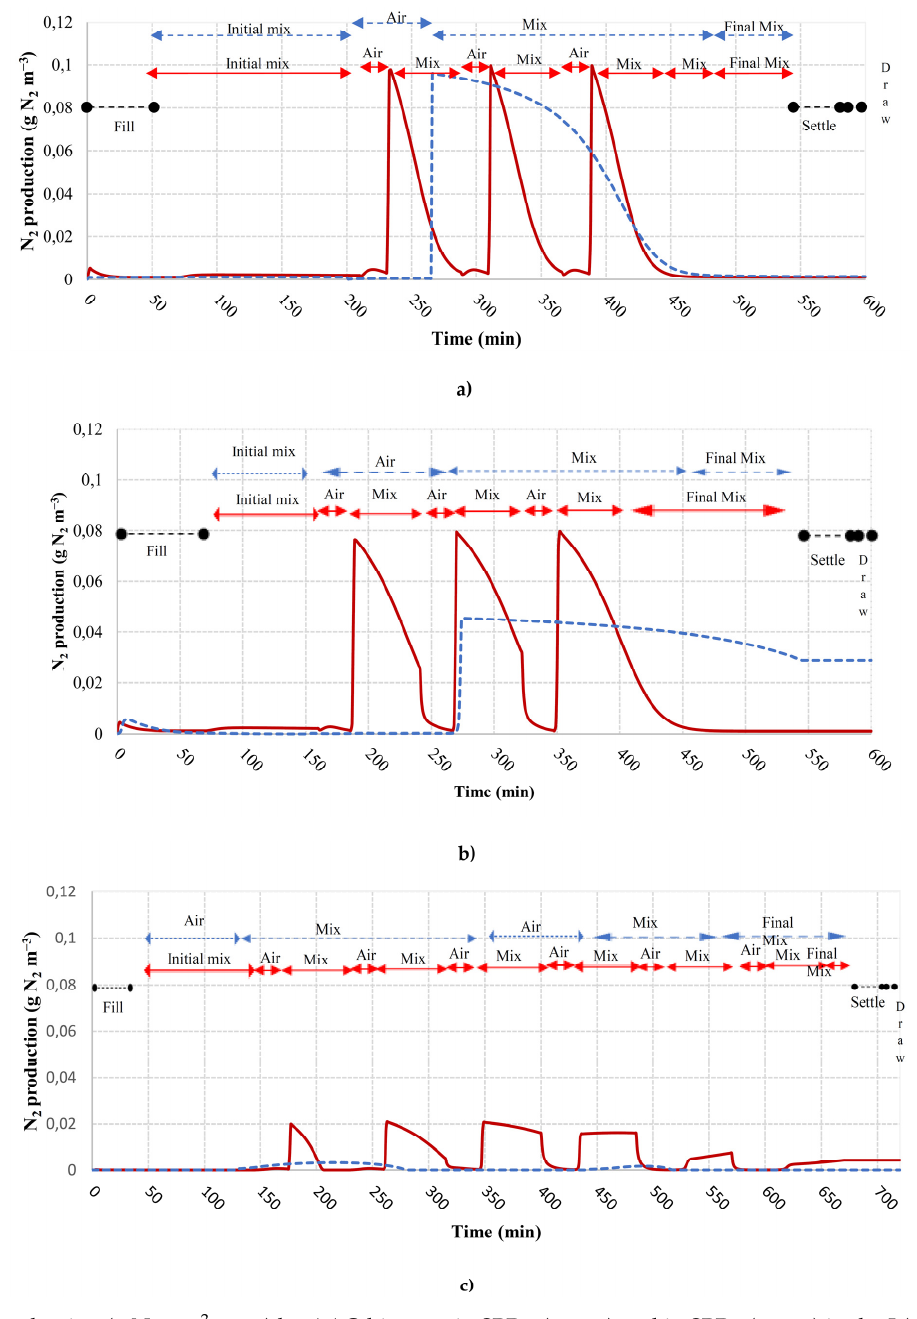
Figure 5. N 2 production (g N 2 m − 3 reactor ) by AAO biomass in SBR A ( Figure 5. N 2 production (g N 2 m -3reactor ) by AAO biomass in SBR A ( ) and in SBR B ( ) in the I ( a ), II ( b ) and III ( c ) ) and in SBR B ( Figure 5. N 2 production (g N 2 m -3reactor ) by AAO biomass in SBR A ( ) and in SBR B ( ) in the I ( a ), II ( b ) and III ( c ) ) in the I ( a ), II ( b ) and III Figure 5. N 2 production (g N 2 m -3reactor ) by AAO biomass in SBR A ( ) and in SBR B ( ) in the I ( a ), II ( b ) and III ( c ) Figure 5. N 2 production (g N 2 m -3reactor ) by AAO biomass in SBR A ( ) and in SBR B ( ) in the I ( a ), II ( b ) and III ( c ) Figure 5. N 2 production (g N 2 m -3reactor ) by AAO biomass in SBR A ( ) and in SBR B ( ) in the I ( a ), II ( b ) and III ( c ) Figure 5. N 2 production (g N 2 m -3reactor ) by AAO biomass in SBR A ( ) and in SBR B ( ) in the I ( a ), II ( b ) and III ( c ) track study. ( ) Duration of aeration and mixing phases in SBR A , ( ) Duration of aeration and mixing phases in track study. ( ) Duration of aeration and mixing phases in SBR A , ( ) Duration of aeration and mixing phases in track study. ( ) Duration of aeration and mixing phases in SBR A , ( ) Duration of aeration and mixing phases in track study. ( ) Duration of aeration and mixing phases in SBR A , ( ) Duration of aeration and mixing phases in track study. ( ) Duration of aeration and mixing phases in SBR A , ( ) Duration of aeration and mixing phases in ( c ) track study. ( ) Duration of aeration and mixing phases in SBR A , ( ) Duration of aeration and mixing phases in track study. ( ) Duration of aeration and mixing phases in SBR A , ( ) Duration of aeration and mixing phases in SBR B , ( ) Duration of filling, settle and draw phases in both SBRs. SBR B , ( ) Duration of filling, settle and draw phases in both SBRs. SBR B , ( ) Duration of filling, settle and draw phases in both SBRs. SBR B , ( ) Duration of filling, settle and draw phases in both SBRs. SBR B , ( ) Duration of filling, settle and draw phases in both SBRs. SBR B , ( ) Duration of filling, settle and draw phases in both SBRs. ) Duration of filling, settle and draw phases in both